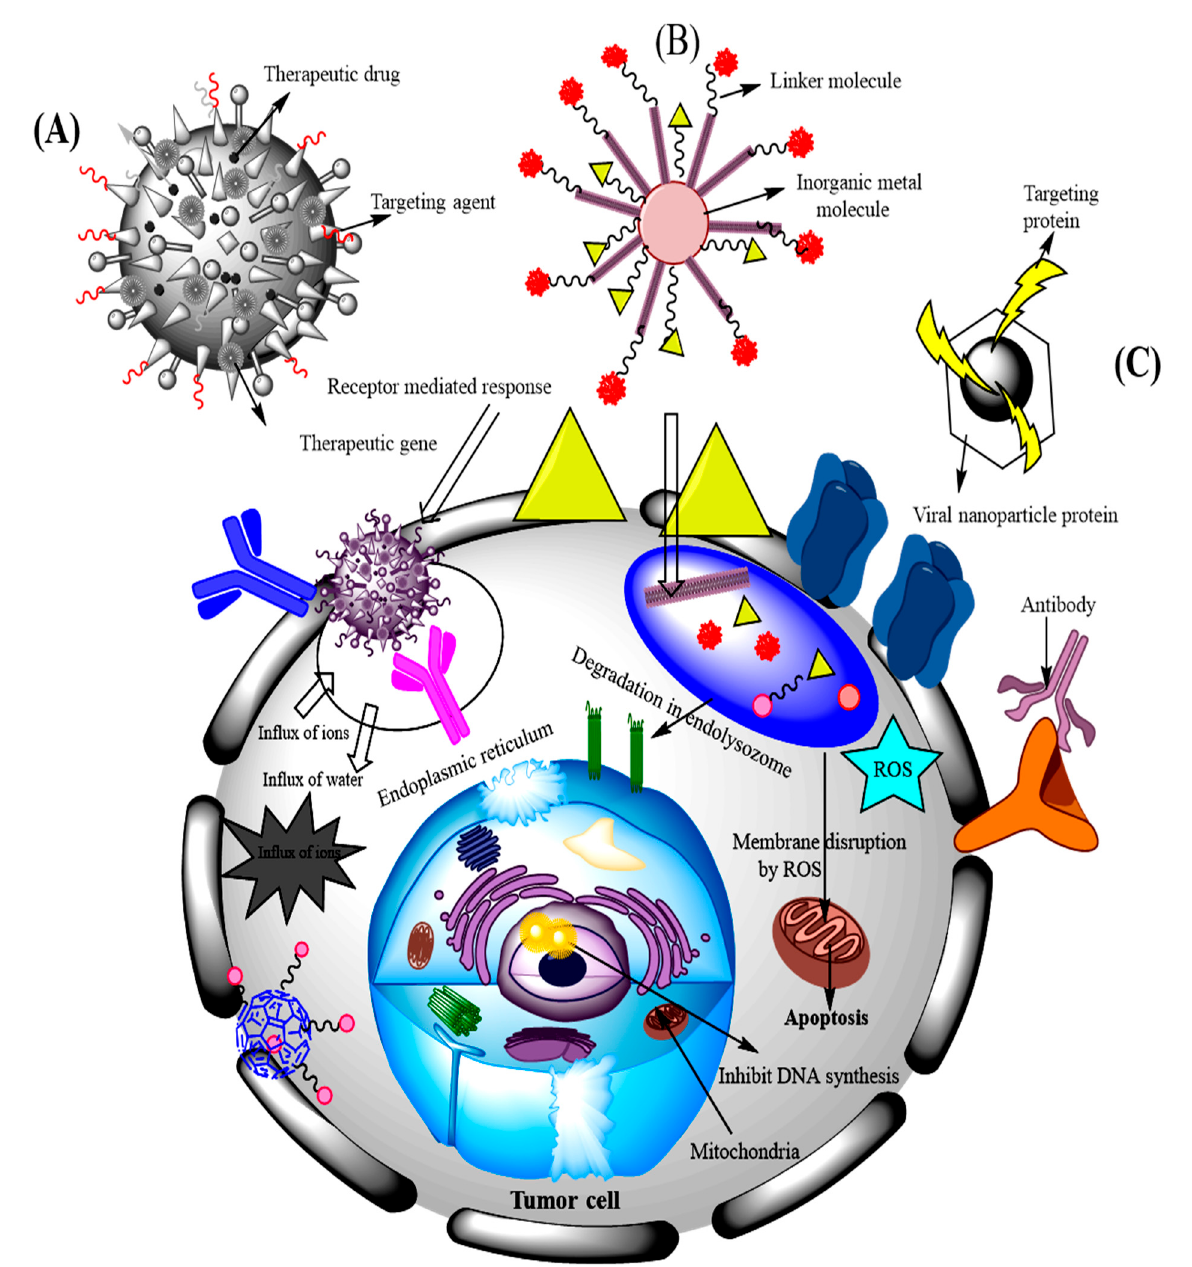
Figure 1. Schematic presentation of various methods for delivery of therapeutic agents against lung cancer including ( A ) polymeric nanoparticle ‐ based approach, ( B ) metallic nanoparticle ‐ based approach and ( C ) bioparticle ‐ based approach.